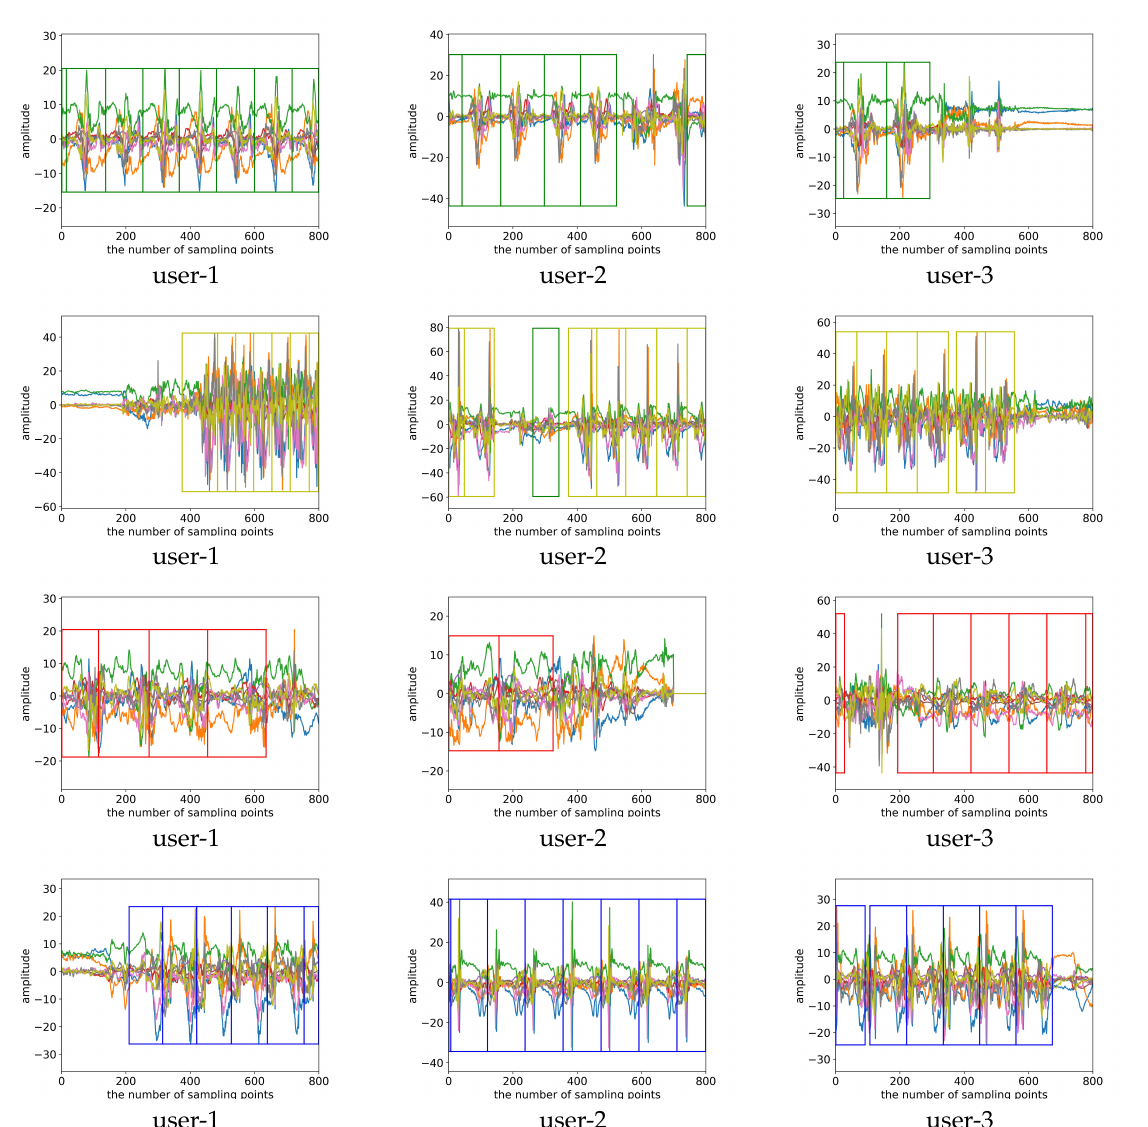
Figure 11. Visualization of the detection and recognition results of our proposed algorithm. The green box indicates the detected breaststroke interval, the yellow box indicates the detected butterfly interval, the red box indicates the detected backstroke interval, and the blue box indicates the detected freestyle